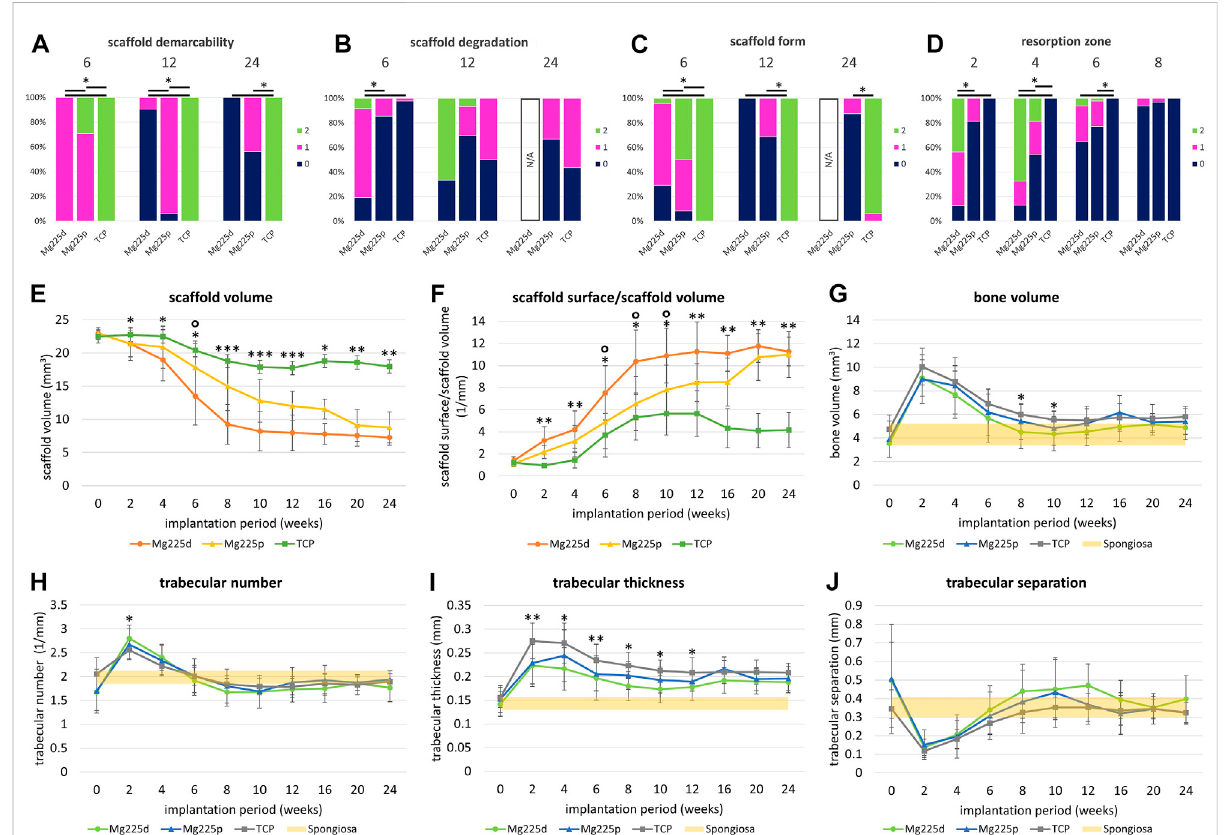
FIGURE 5 (A – D) Semi-quantitative in-vivo µCT evaluation of Mg225d, Mg225p and TCP. *: Signi fi cant differences ( p < 0.05) between the individual materials. (A) Scaffold demarcability, (B) scaffold degradation and (C) scaffold form after 6, 12 and 24 weeks. Due to the lack of demarcability of all Mg225d scaffolds from the bone tissue from week 16 onwards, the evaluation of scaffold degradation and form was no longer possible at week 24. (D) Resorption zone after 2, 4, 6 and 8 weeks (E – J) Quantitative in-vivo µCT evaluation of the scaffolds [ (E) scaffold volume (SV), (F) scaffold surface/scaffold volume (SS/SV)] and adjacent cancellous bone [ (G) bone volume (BV), (H) trabecular number (Tb.N), (I) trabecular thickness (Tb.Th), (J) trabecular separation (Tb.Sp)] compared to native cancellous bone. Signi fi cant differences ( p < 0.05) are marked with *: Mg225d — TCP, °